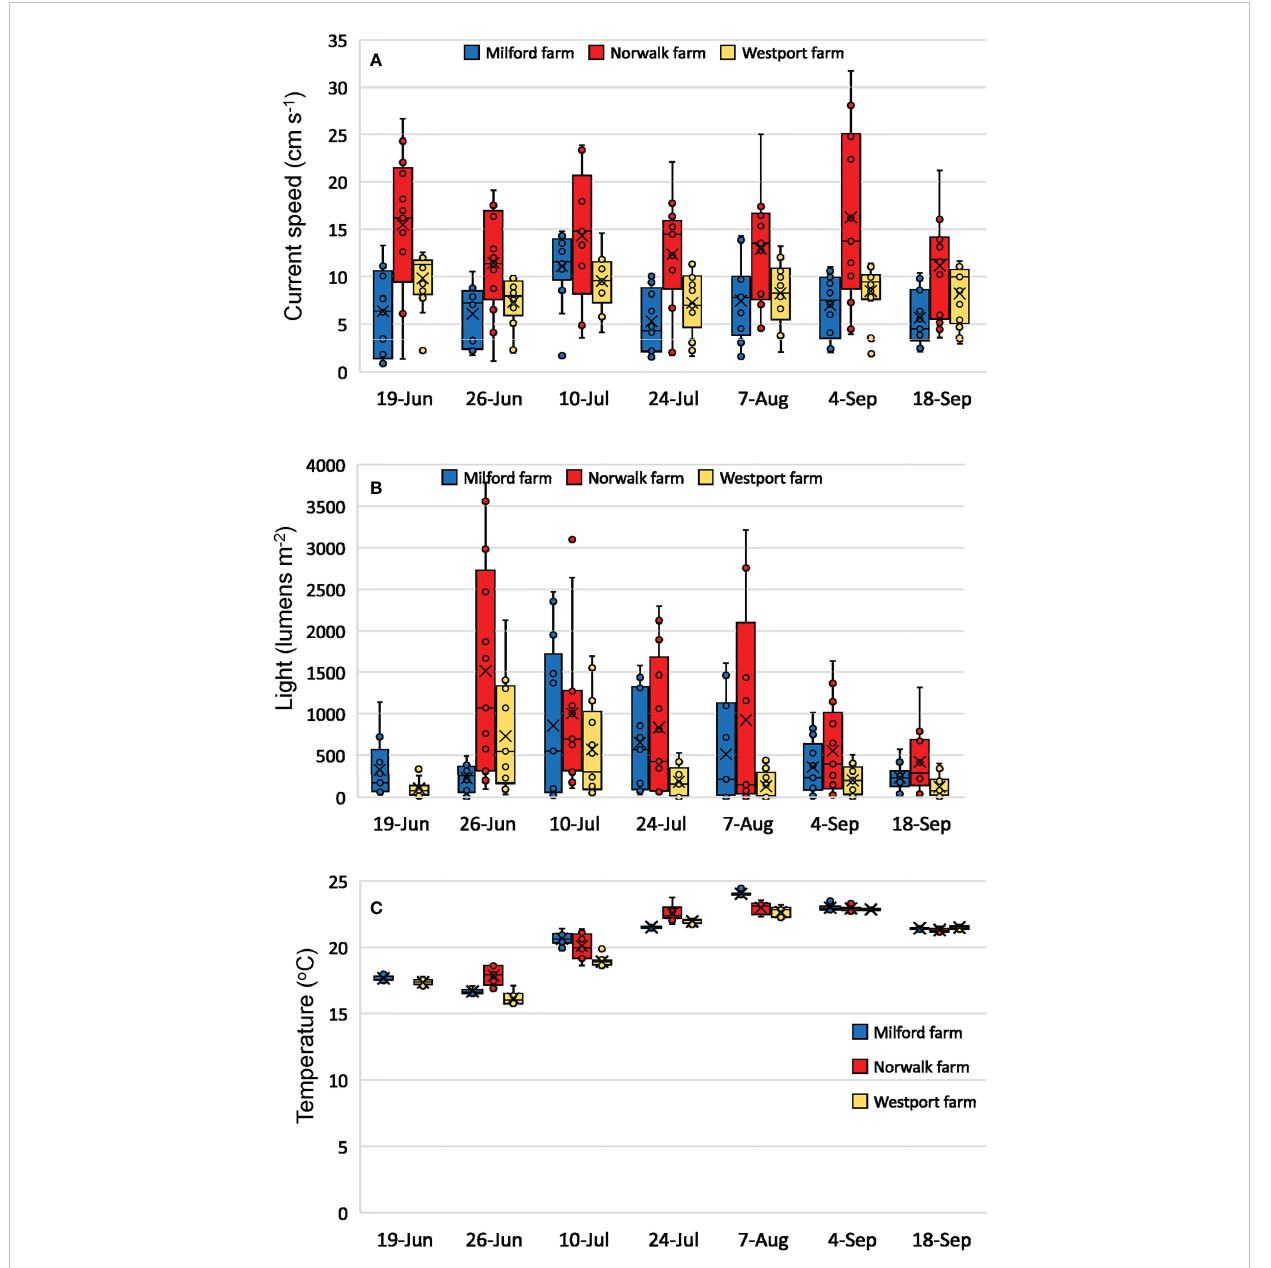
FIGURE 8 Environmental conditions at the three commercial shell fi sh farms sampled in 2019. Mean current speed, light, and temperature were generated for each hourly interval during which cameras were recording. Boxplots indicate 25%, 50%, and 75% quartiles of the 13 hourly intervals on each date, mean is indicated by the ‘ x ’ symbol, and whiskers are set to 1.5 times the interquartile range. (A) current speed (cm s -1 ), (B) light (lumens m -2 ), (C) temperature